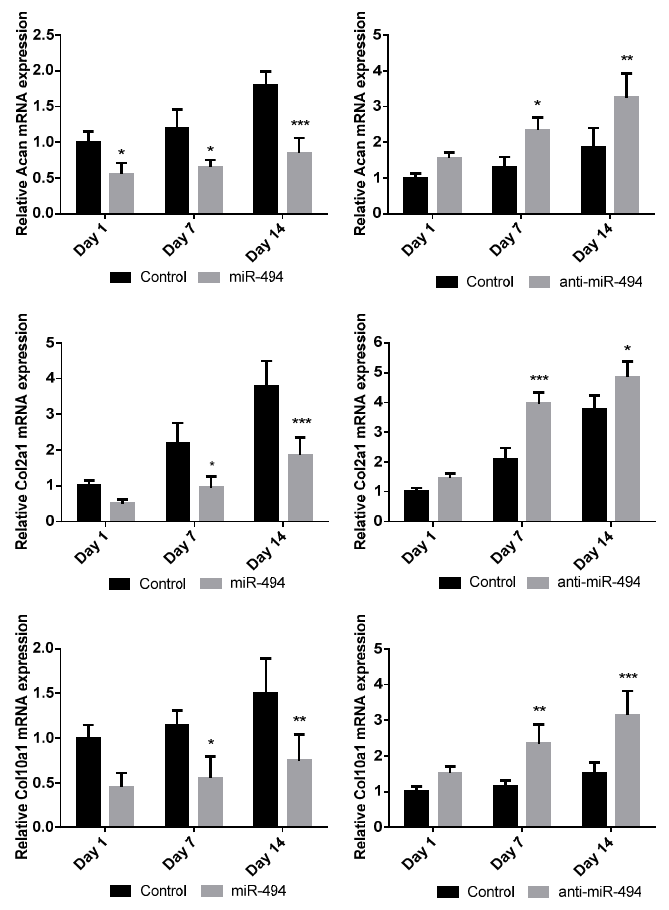
Figure 6. The miR-494 inhibits chondrogenic differentiation in C3H10T1/2 cells. The miR-494, anti-miR-494, or inactive controls were transfected into C3H10T1/2 cells. Expressions of chondrogenic differentiation markers (Acan, Col2a1, and Col10a1) were detected by QPCR at day 1, 7, and 14 after transfection. Note: Data was represented as mean ± SD, * p < 0.05, ** p < 0.01, *** p < 0.001.